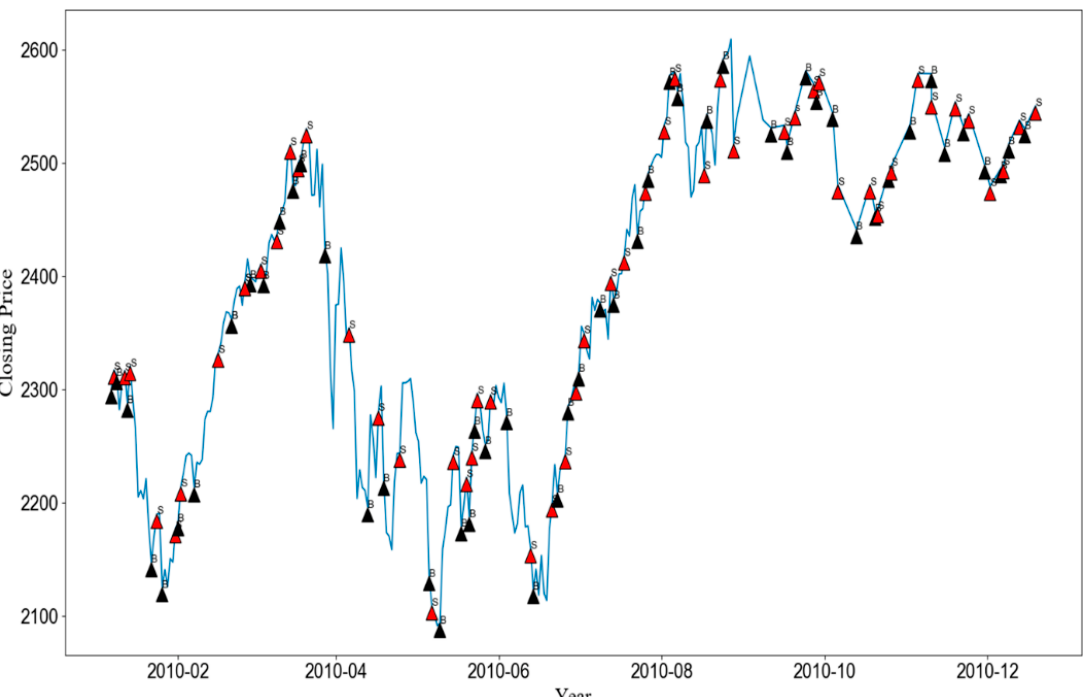
Figure 7. An example of detail transaction by our method. “B” and “S” denote the buy and sell actions, respectively.